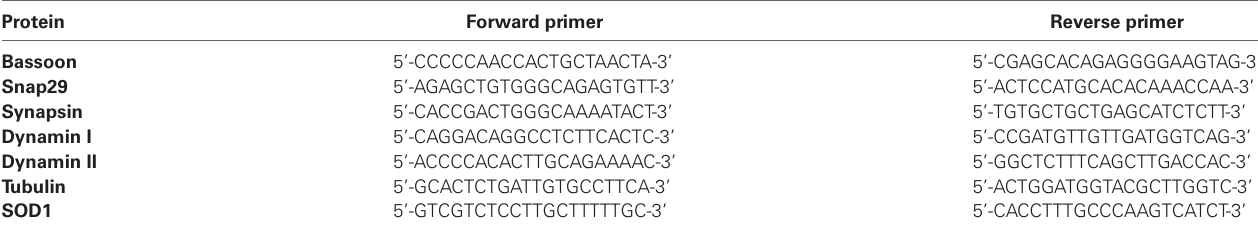
Table 1 | The list and sequence of primers used for RT-PCR analysis .